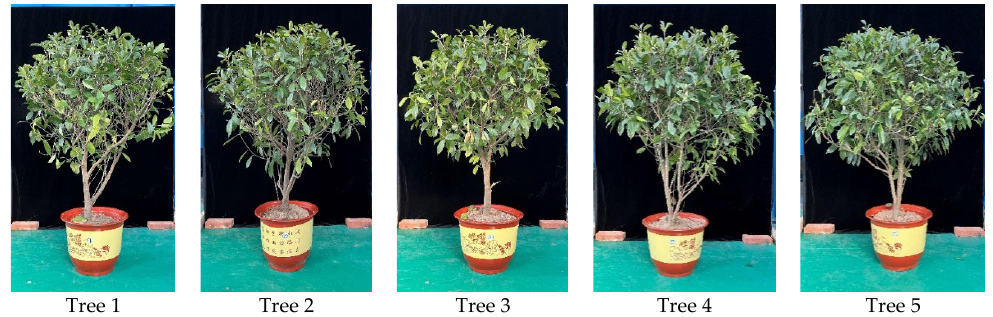
Figure 5. Trees with different densities.